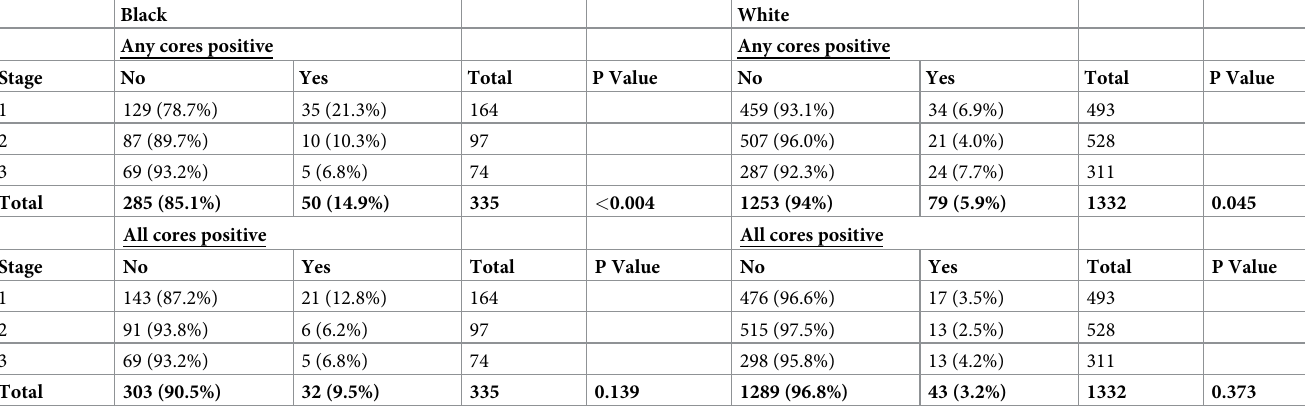
Table 4. GSTP1 protein staining by pathological stage in Black and White patients. Black White Any cores